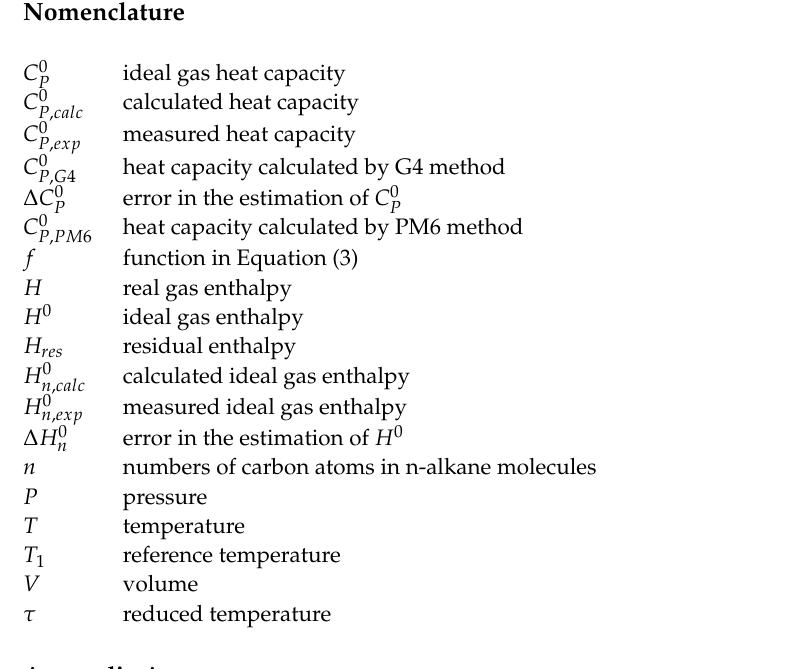
Table A1. Data for C 0